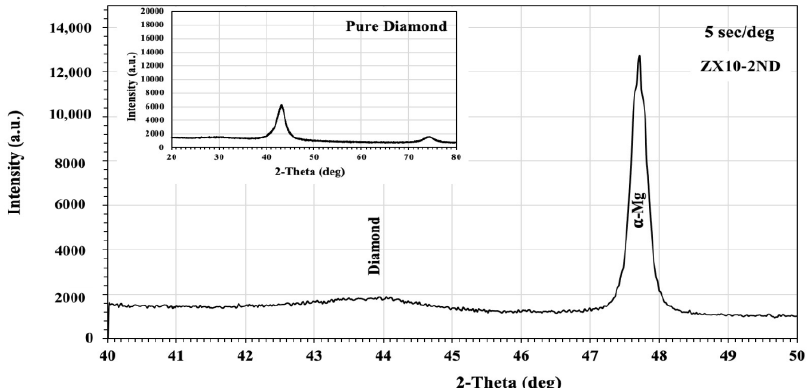
Figure 2. The X-ray diffraction analysis pattern of the ZX10-2ND.